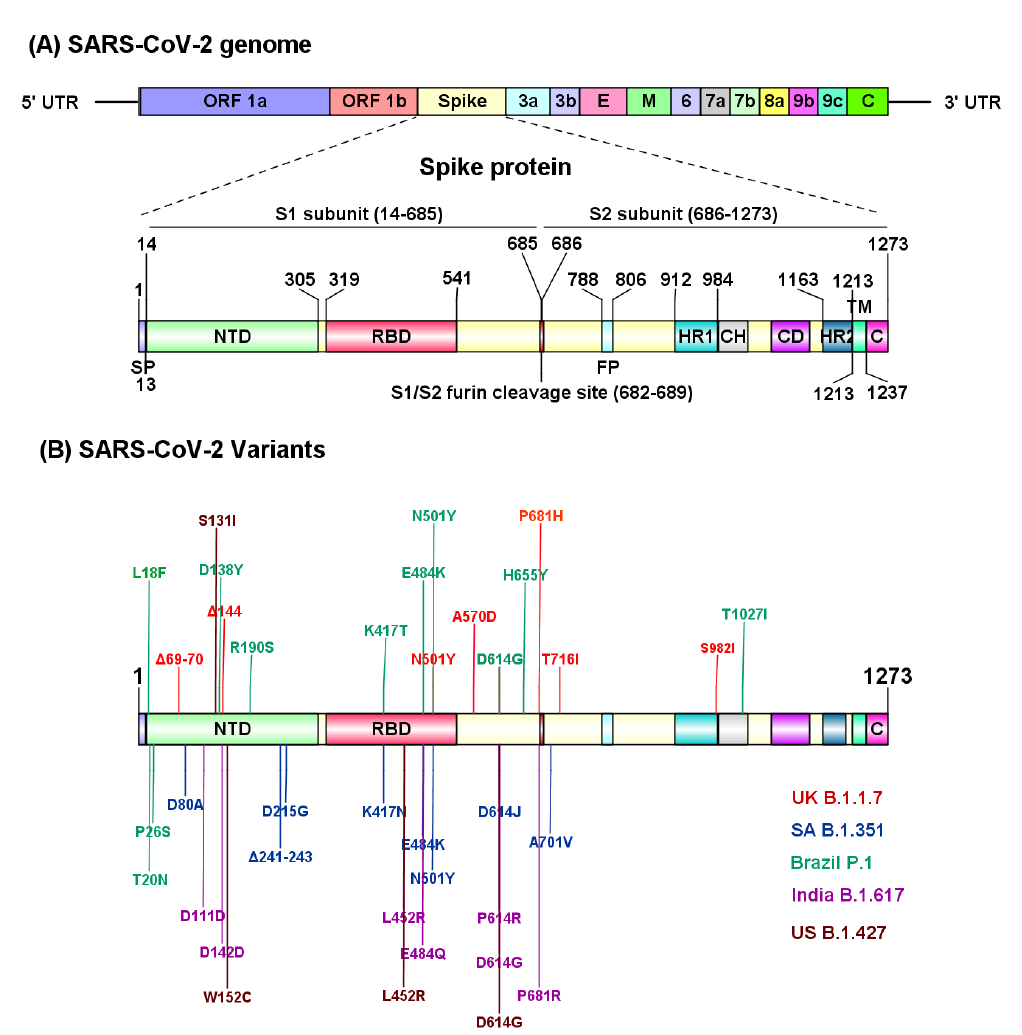
Figure 2. Structural regions of SARS-CoV-2 involved in the pathogenicity. ( A ) SARS-CoV-2 genomic organization and structural components of spike (S) protein. The furin cleavage site (682–689 residues) at the junction of S1 and S2 subunit is critical to facilitate viral fusion and entry to host cells. ( B ) SARS-CoV-2 variants with identified mutation sites in the structural region. UTR, untranslated region; SP, signal peptide; FP, fusion peptide; HR, heptad repeat domain; TM, transmembrane domain; CP, cytoplasmic domain. UK, United Kingdom; SA, South Africa; US, United states. This figure was prepared using IBS 1.0.3 [31].